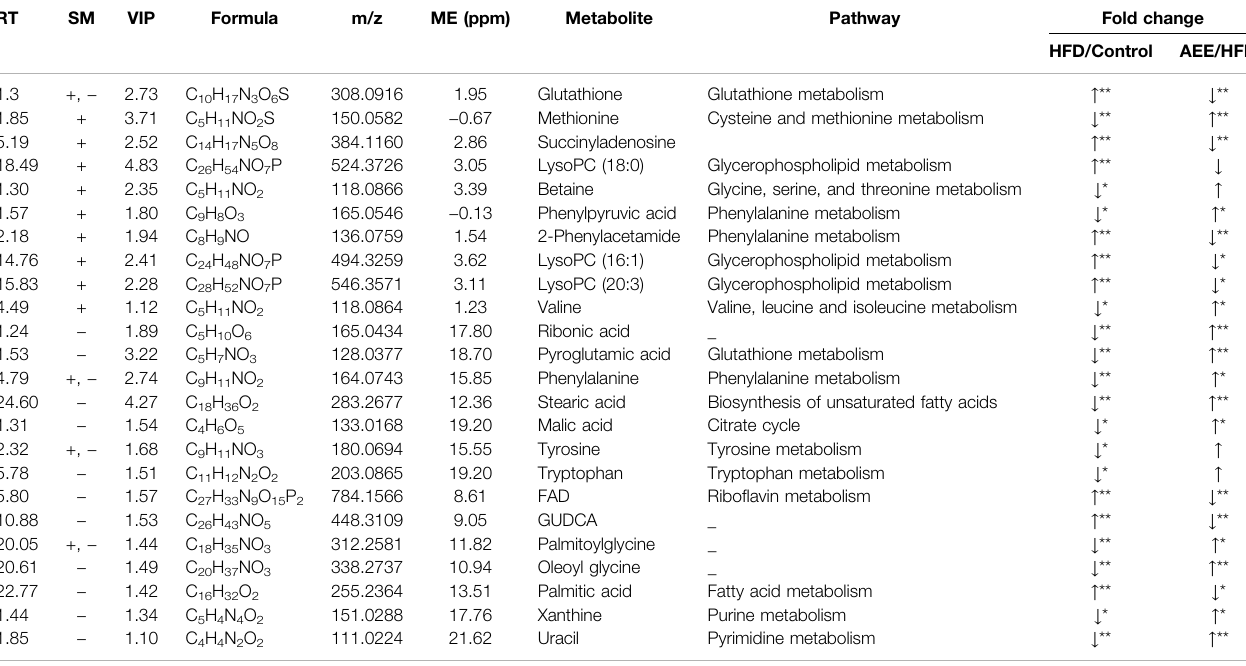
TABLE 1 | Metabolites with signi fi cant changes in liver from hamster fed with high fed